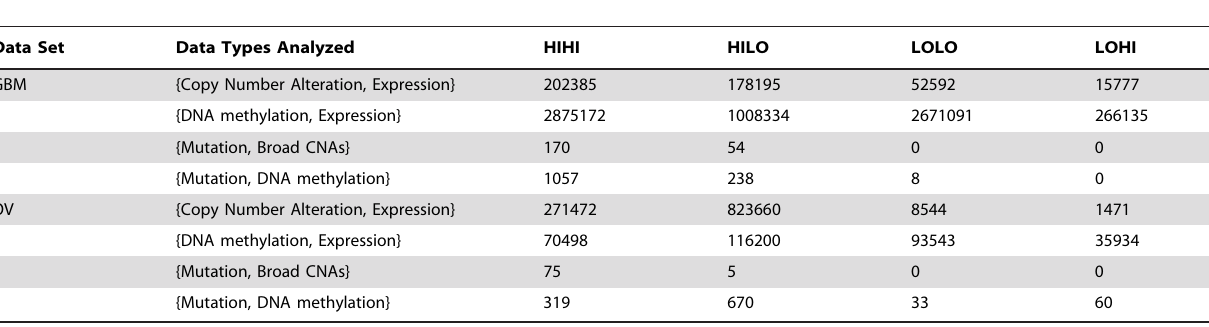
Table 2. Summary